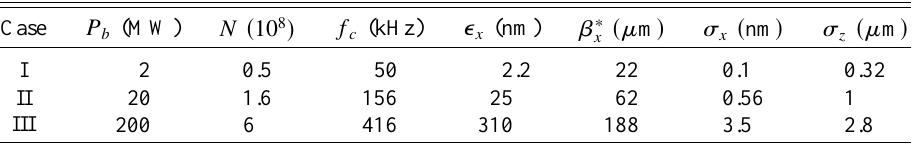
TABLE I. The 5 TeV e 1 e 2 , L g (cid:1) 10 35 cm 2 2 s 2 1 collider parameters according to [4].